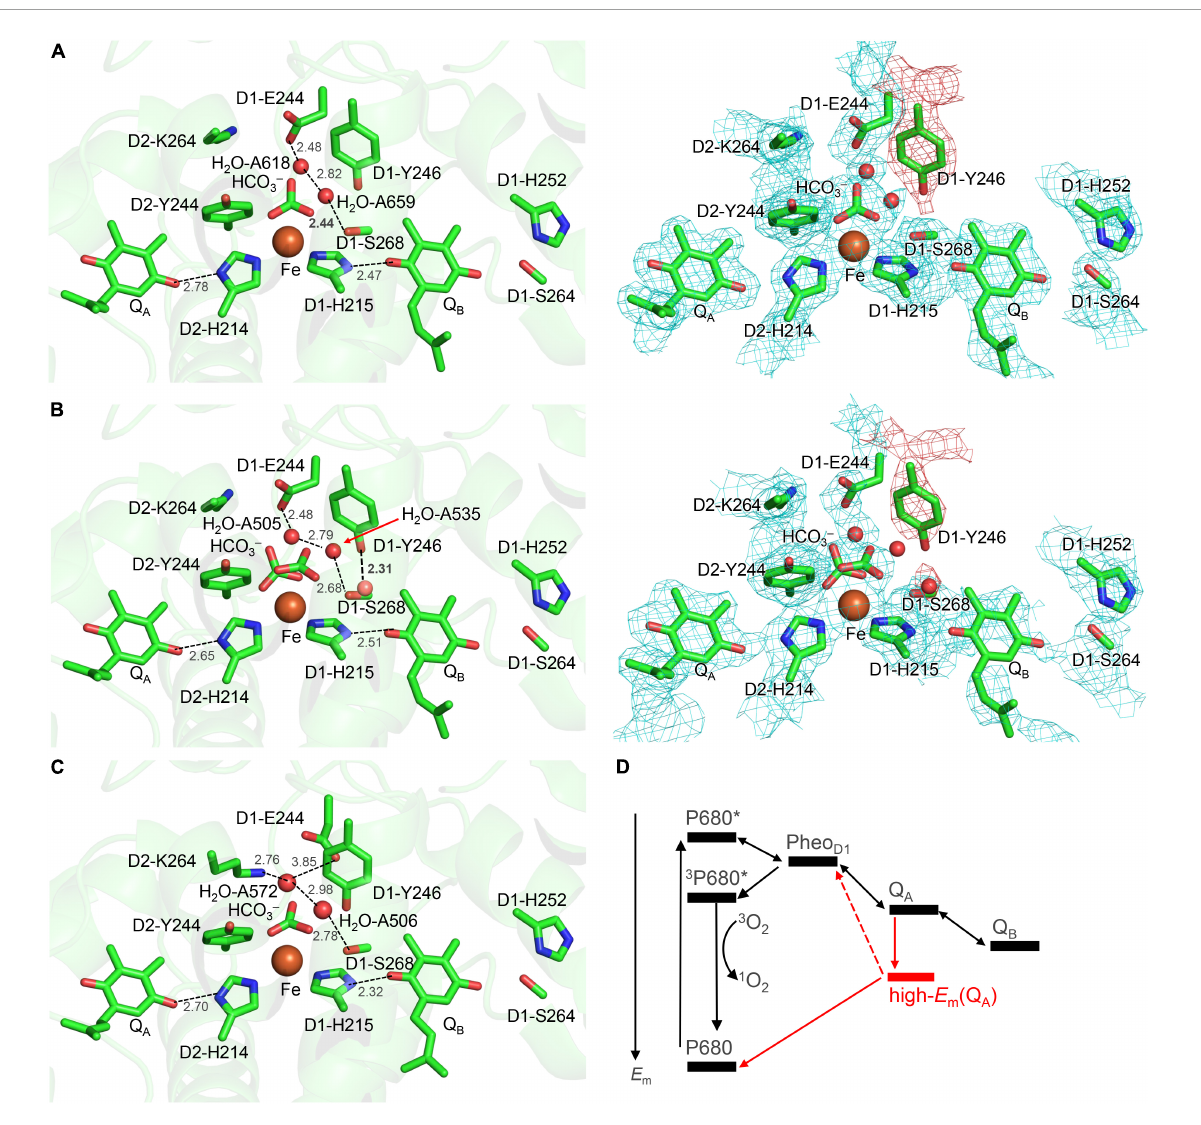
FIGURE1 Overview of the quinone binding sites. (A) X-ray crystal structure of PSII from Thermosynechococcus vulcanus (PDB code, 3WU2) (Umena et al., 2011) and electron density map. (B) X-ray crystal structure of the PsbM-deleted PSII from Thermosynechococcus vestitus BP-1 (PDB code, 5H2F) (Uto et al., 2017) and electron density map. (C) Cryo-electron microscopy structure of PSII from Synechocystis sp. PCC 6803 (PDB code, 7N8O) (Ferreira et al., 2004). Dotted lines indicate H-bonds. The density of the D1-Tyr246 moiety, including the adjacent water molecule in the PsbM-deleted structure, is indicated by the red mesh. (D) Energetics of forward and backward electron-transfer processes. Processes occurring via the high- E m Q A form are shown in red. P680* denotes the electronically excited P680.